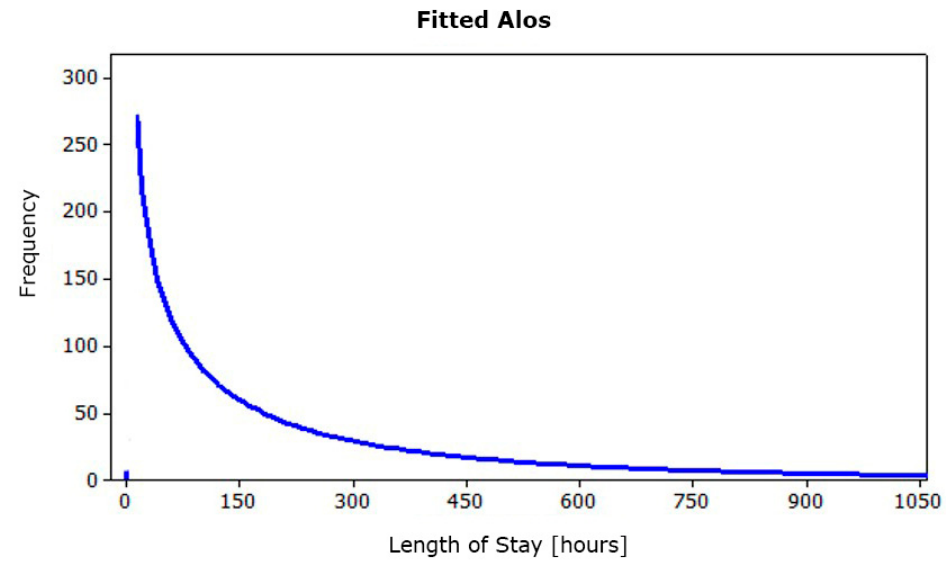
Figure 5. Fitted ALOS.